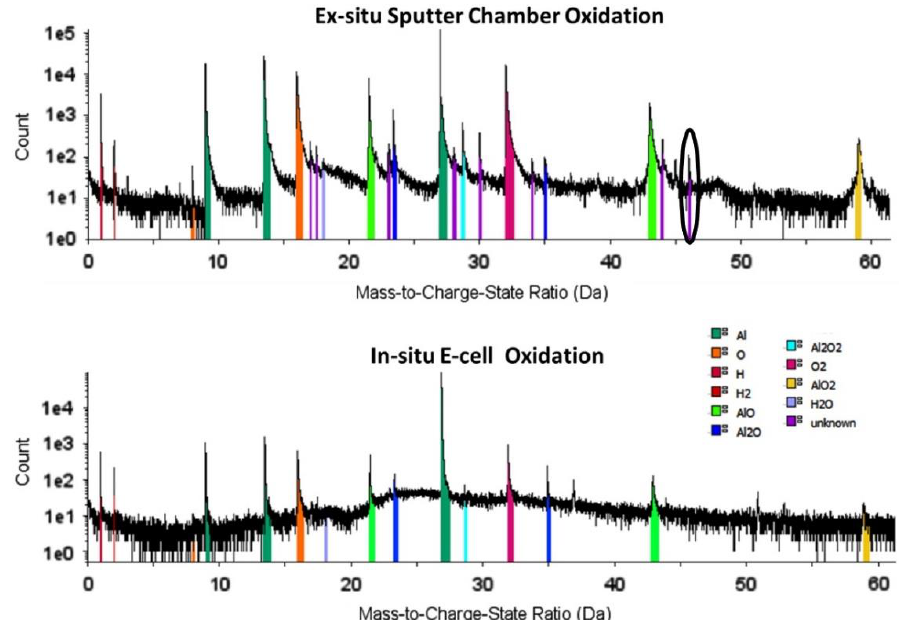
Figure 3. Mass spectra from APT analysis of Al oxidation performed under the same conditions but different reaction cells, ex situ (top spectra) and in situ (bottom spectra) cells, showing the lower contamination and higher resolution of the in situ environmental cell experiment. Reprinted from [86], Copyright (2014), with permission from